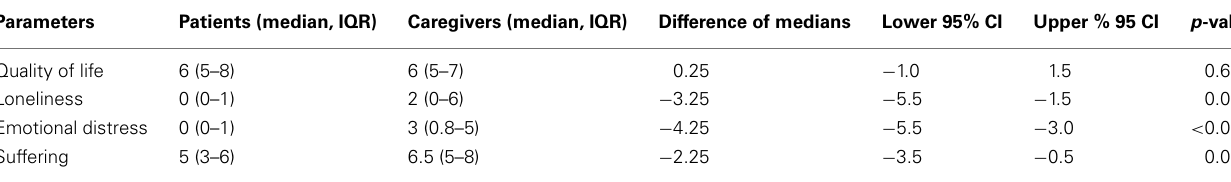
Table 4 | Quality of life and burden of disease variables rated on self-rating scales